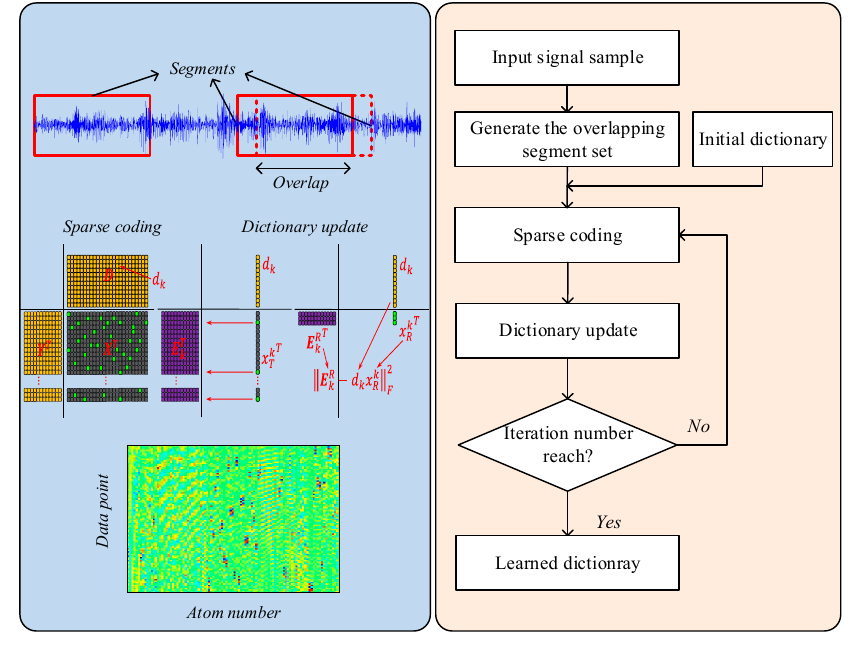
Figure 2. Workflow of dictionary learning algorithm. Table 1. Parameters of K-SVD dictionary learning.